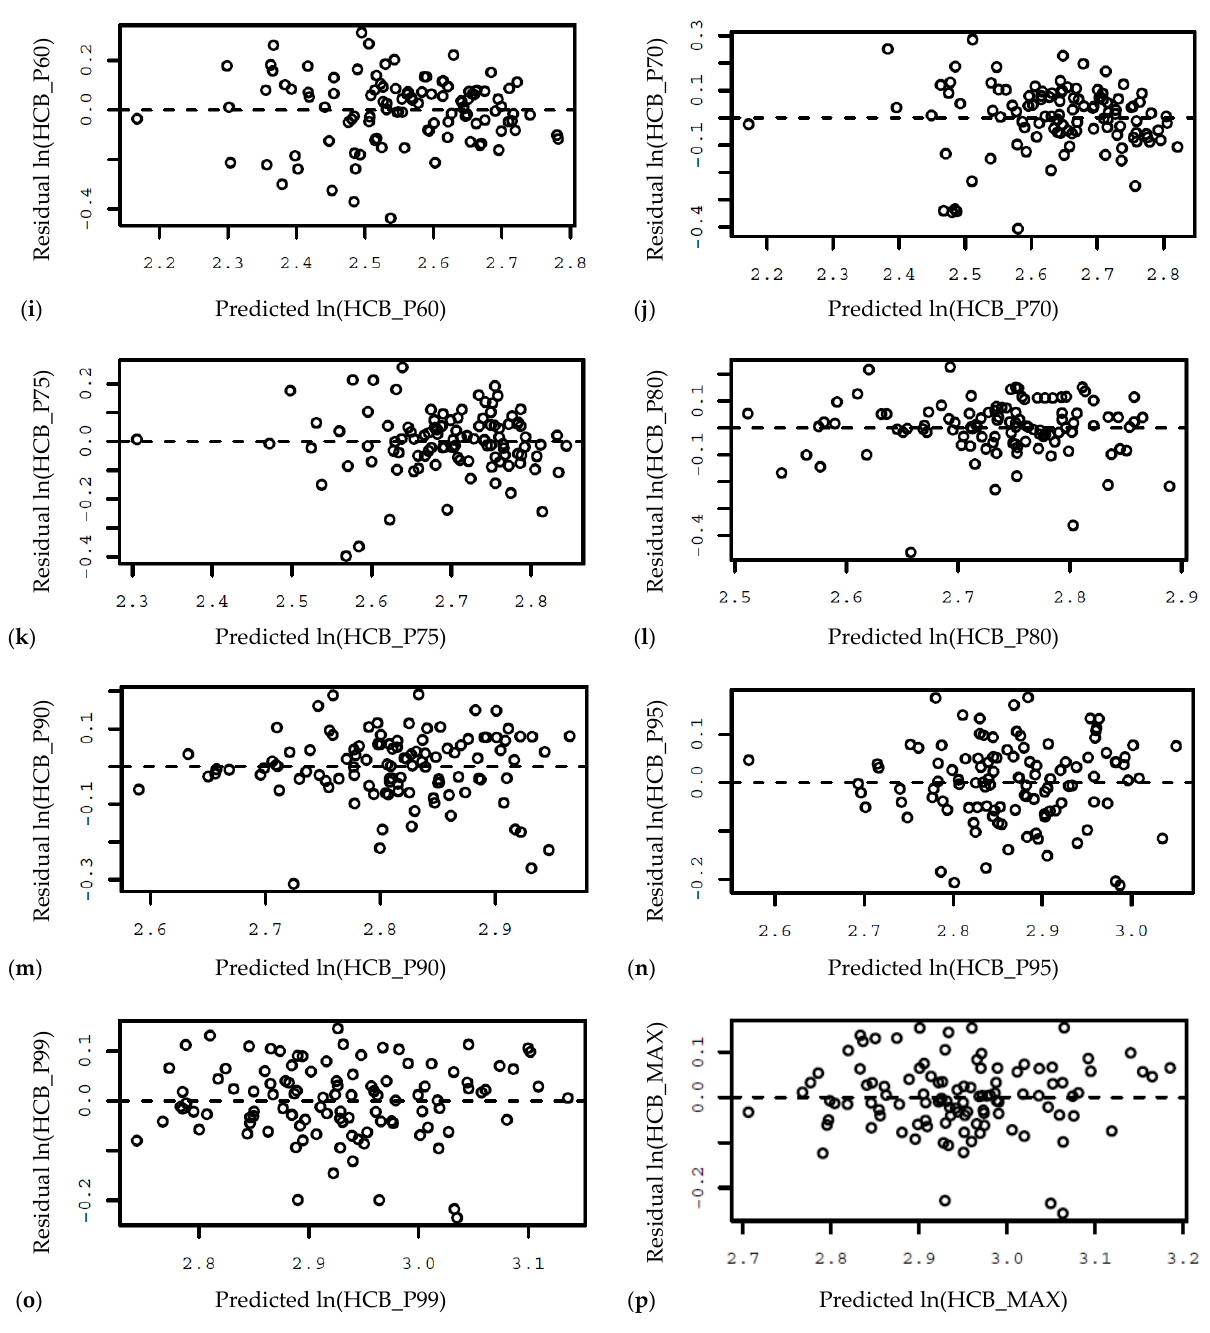
Figure A4. Residuals versus predicted values plots of: ( a ) HCB MIN model; ( b ) HCB P10 model; ( c ) HCB P20 model; ( d ) HCB P25 model; ( e ) HCB P40 model; ( f ) HCB P40 model; ( g ) HCB P50 model; ( h ) HCB- MEAN model; ( i ) HCB P60 model; ( j ) HCB P70 model; ( k ) HCB P75 model; ( l ) HCB P80 model; ( m ) HCB P90 model; ( n ) HCB P95 model; ( o ) HCB P99 model; and ( p ) HCB MAX model.